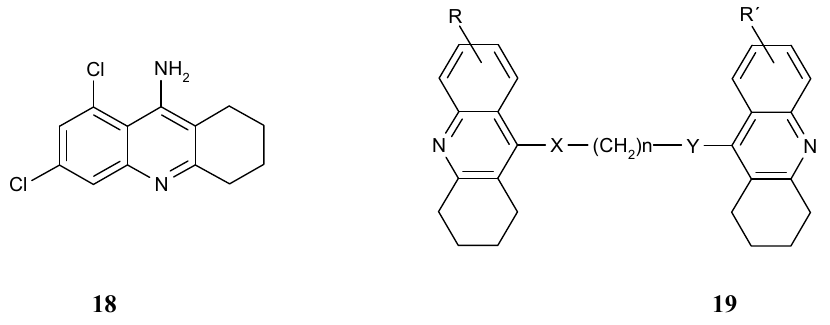
Figure 8. 9-Amino-6,8-dichloro-1,2,3,4-tetrahydroacridine 18 , homotacrine hybrids 19 .